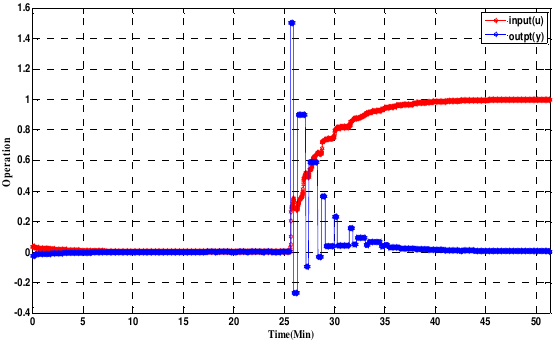
Fig. 11. Step response of the designed system. The 85% duty cycle control is obtained with the operation of the system during the transient region (0-10) min as shown in Fig.12.